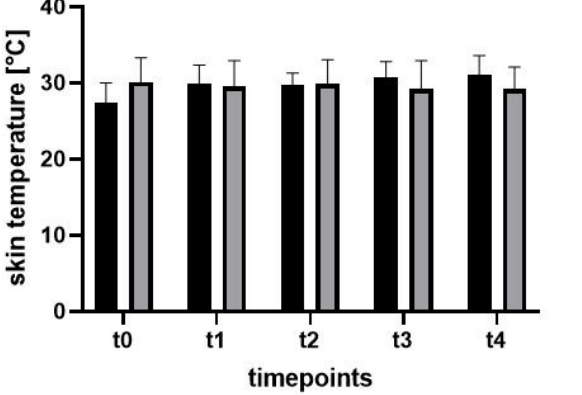
Figure 5. Tissue oxygen saturation of a patient’s hand at different timepoints. Skin temperature in patients: